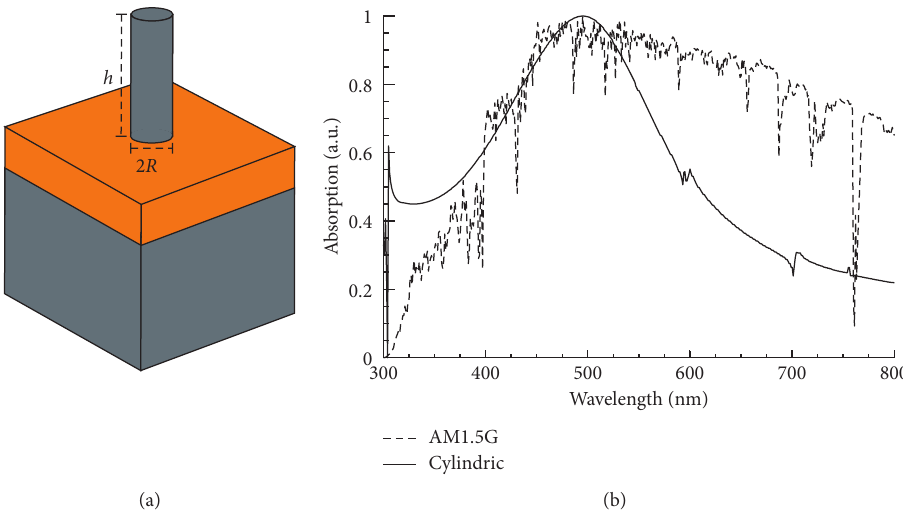
Figure 9: (a) Unit cell of the conventional OSC structure with the cylindrical nanoantenna. (b) Absorption A ( λ ) for OSC with the optimized cylindrical nanoantenna related to absorption AM1.5G [20].